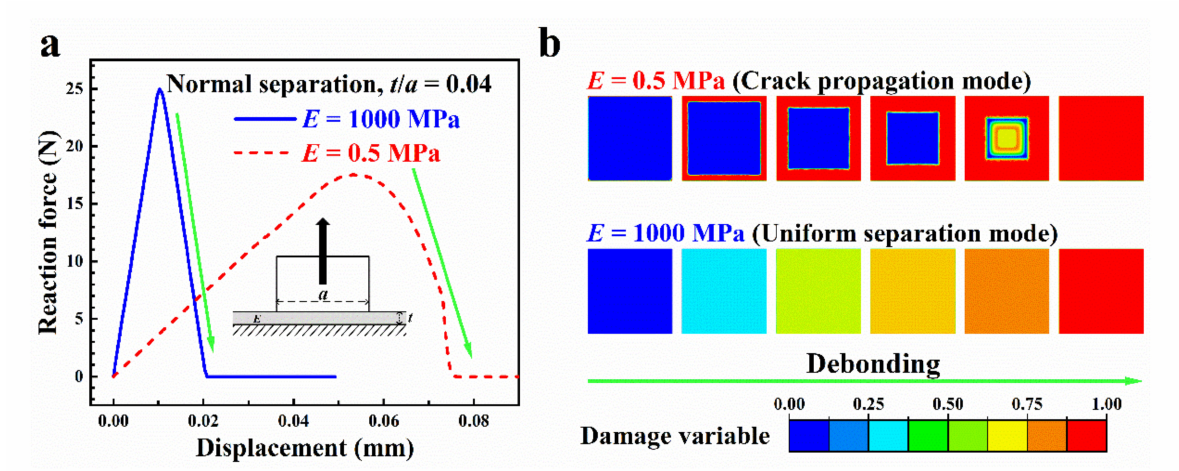
Figure 8. ( a ) Force–displacement curves and ( b ) changes of the interface damage variable during detachment for normal separation, for E = 0.5 and 1000 MPa ( t / a =